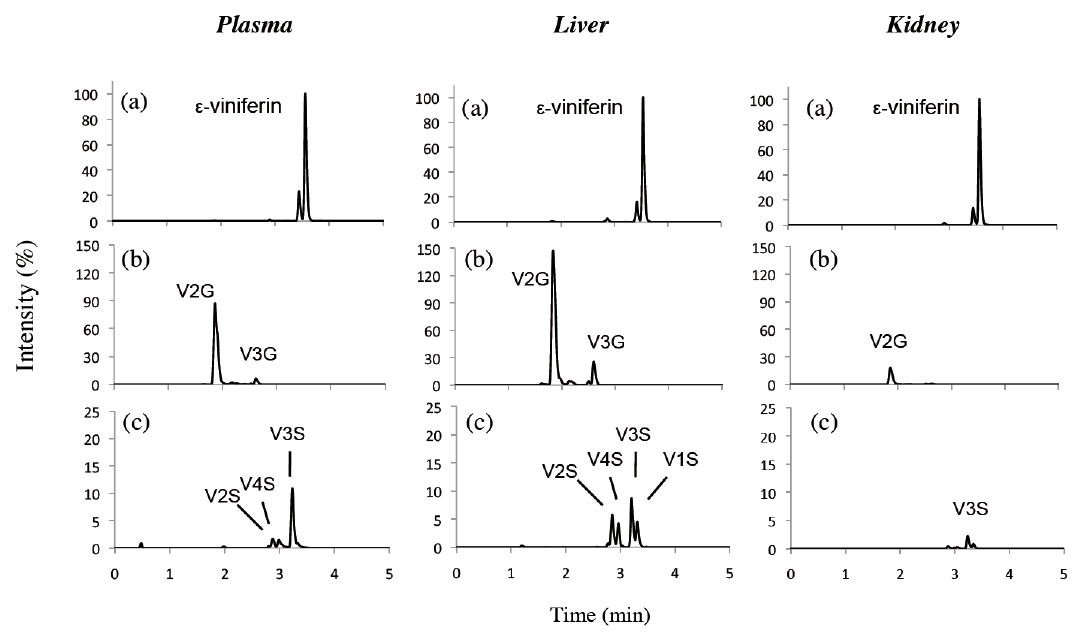
Figure 3. Liquid chromatography-high resolution mass spectrometry (LC-HRMS) extracted ions chromatograms of plasma, liver and kidney extracts from rat 1h after IP administration. ( a ) ε -viniferin ( m/z 453.1343), ( b ) glucuronide metabolites ( m/z 629.1664) and ( c ) sulphate metabolites ( m/z